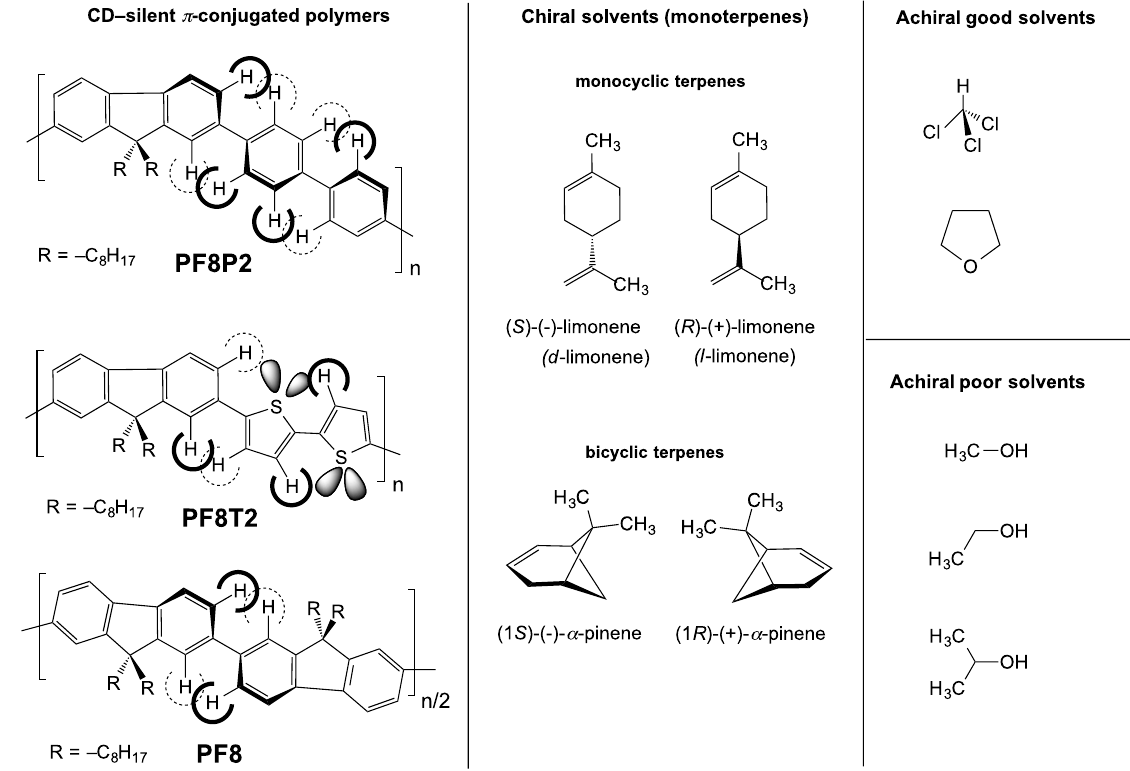
Figure 1. Chemical structure of three  - conjugated polymers ( PF8P2 , PF8T2 [41], and PF8 [42]) and chiral solvents (limonene and  -pinene) and good and poor achiral